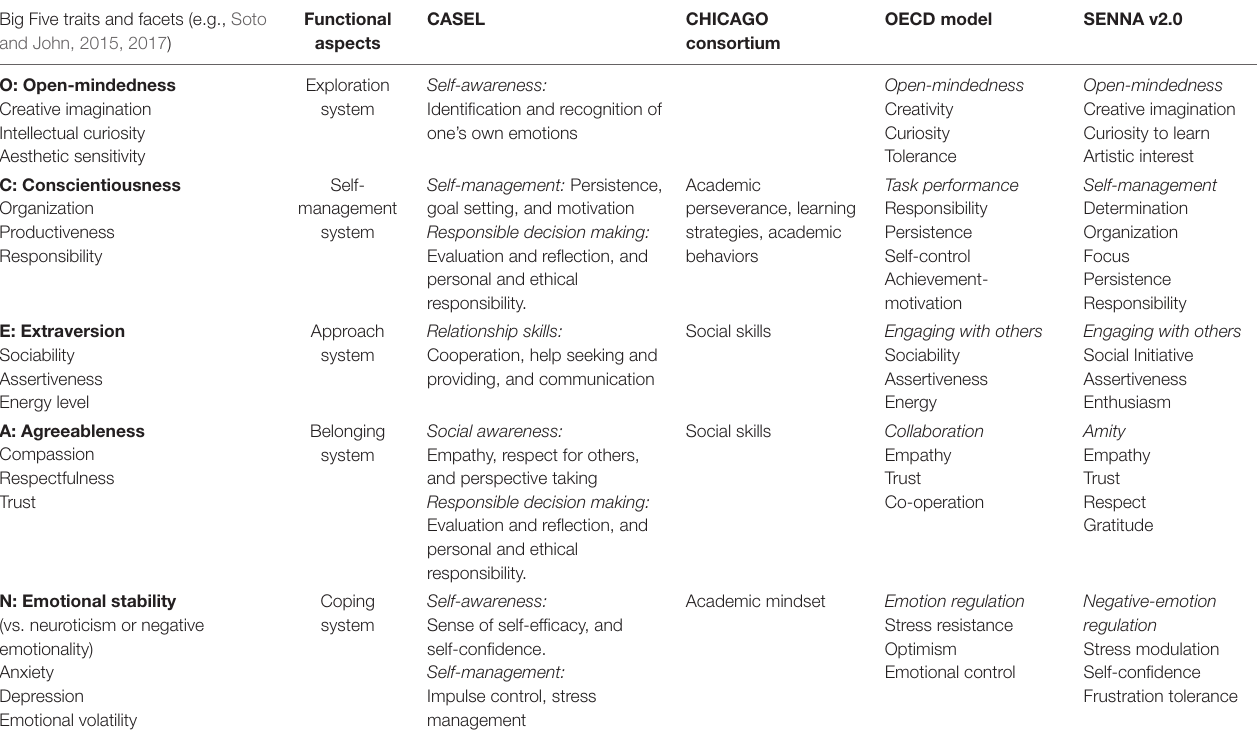
TABLE 1 | Relationship of Big Five traits, functional aspects, and dimensions in major socio-emotional skills frameworks. Big Five traits and facets (e.g., Soto and John, 2015,